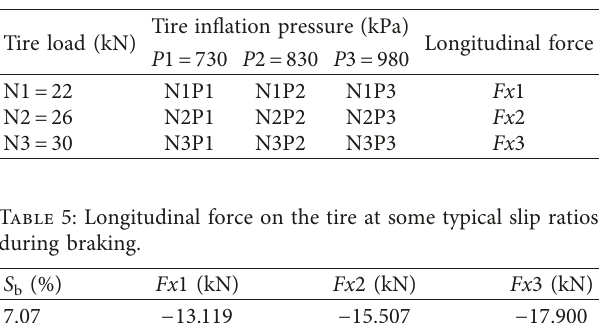
Figure 8: Longitudinal forces on the tire at different slip ratios under braking condition. Table 4: Longitudinal forces corresponding to different combinations.